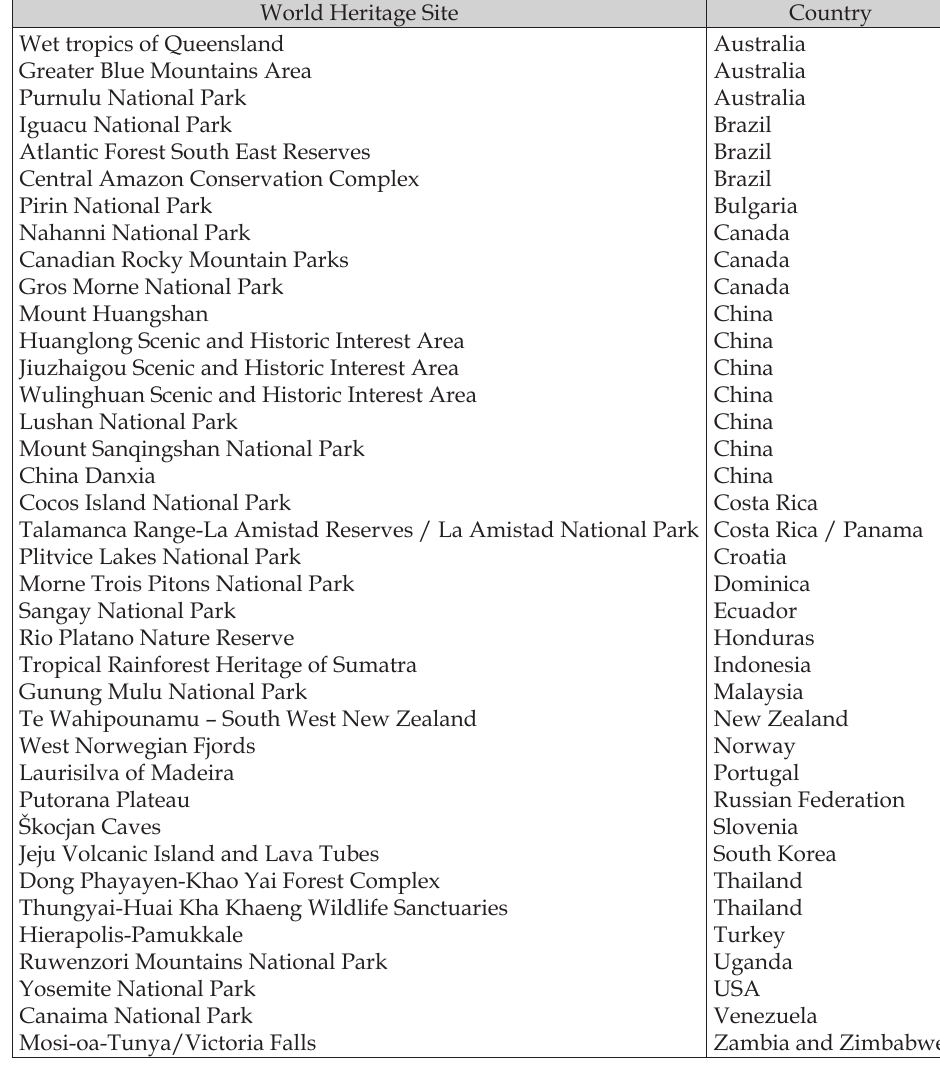
Table 1. World Heritage Sites with waterfalls included in their